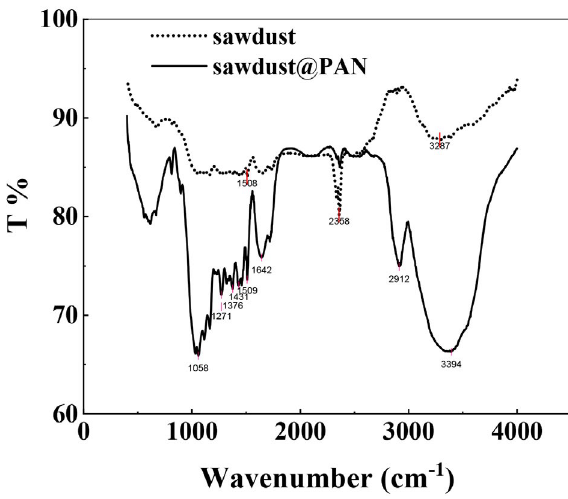
Fig. 2. FTIR spectra of raw sawdust (dot plot) and modified sawdust with polyaniline (solid plot).